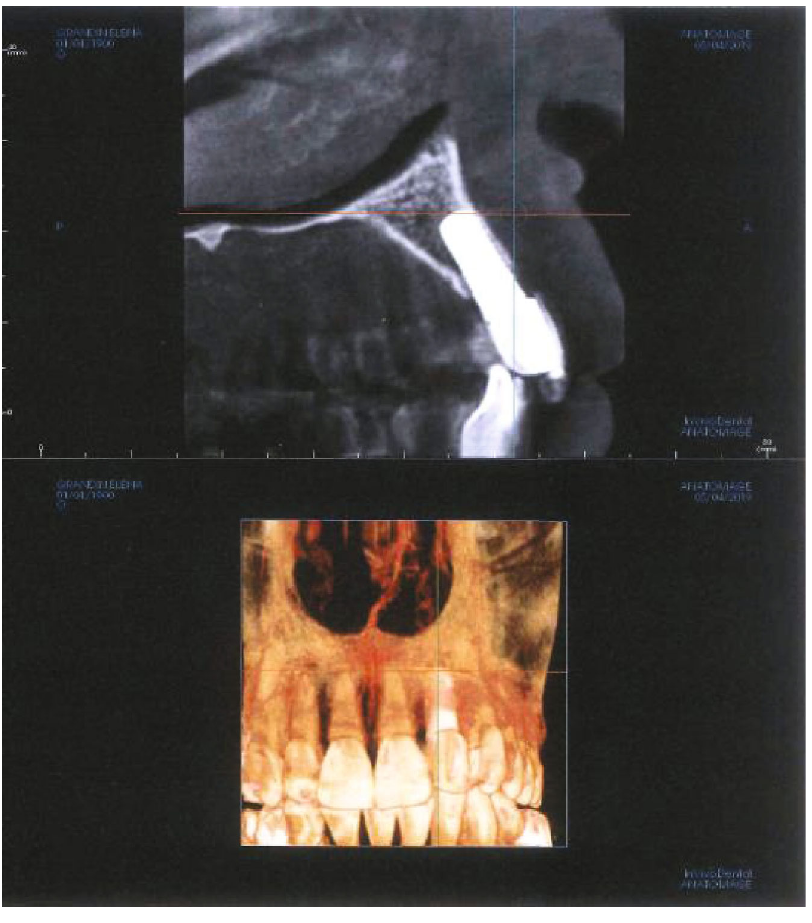
Figure 8: 5-year follow-up. Table 1: Articles about laser treatment and immediate implant